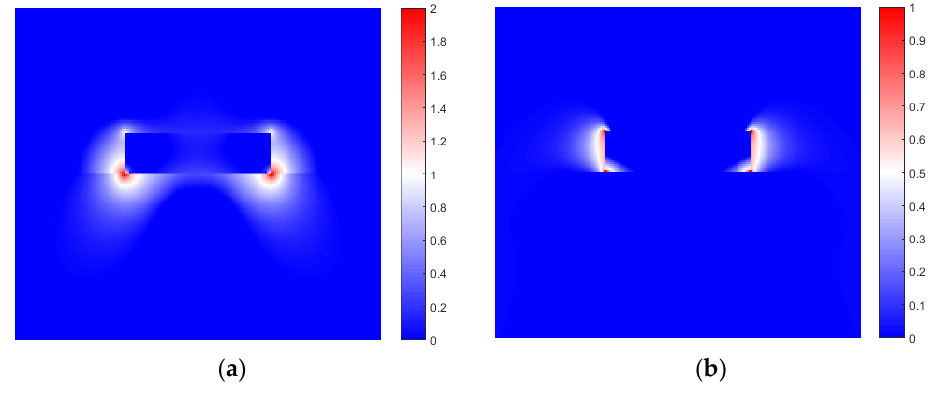
Figure 4. Electric field enhancement the extinction peaks of a 1-μm-high highly doped germanium (n-Ge) particle. The excitation is ( a ) 490 cm −1 and ( b ) 1049 cm −1 , respectively. The scale is logarithmic and the electric field enhancement is normalized to the incident electric field. The plots are for a cross-section through the center of the particle (mid-width) (The incident field is normal to the top surface of the particle and polarized in the length direction).